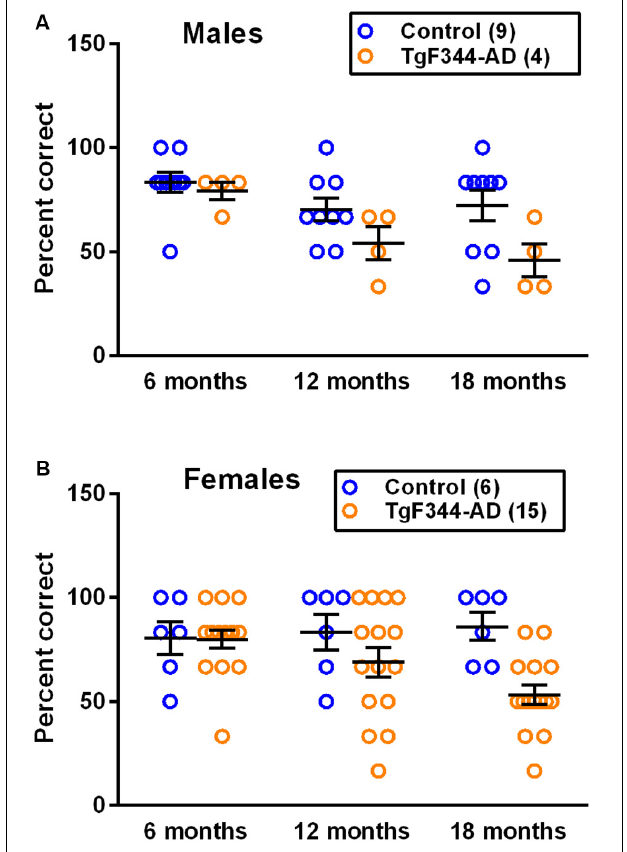
FIGURE 1 | Performance on the reward-alternation T-maze in (A) male and (B) female control and TgF344-AD rats. Each point is the percent correct alternations, and the lines represent the mean ± SEM for the number of male and female control and AD rats indicated in parentheses. The main effect of genotype was statistically significant in both males ( p = 0.015) and females ( p = 0.024). The main effect of age was statistically significant in males ( p = 0.014) but not in females. Results indicate a decreased performance in AD rats in both sexes. In males, performance of both genotypes declines with